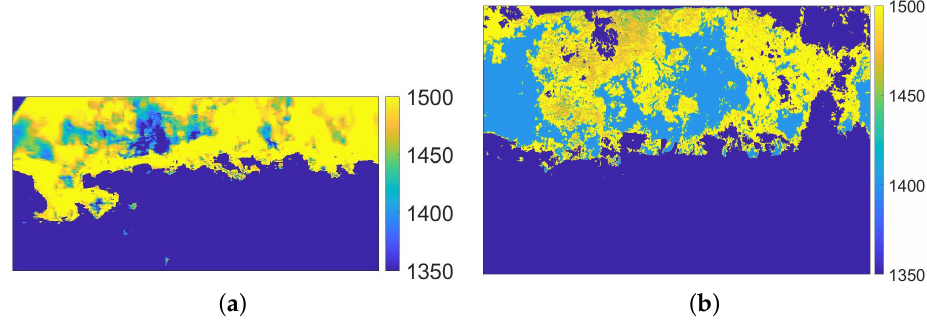
Figure 11. Result of Temperature Field Measurement. ( a ) Innermost Source Image; ( b ) Reference Image.